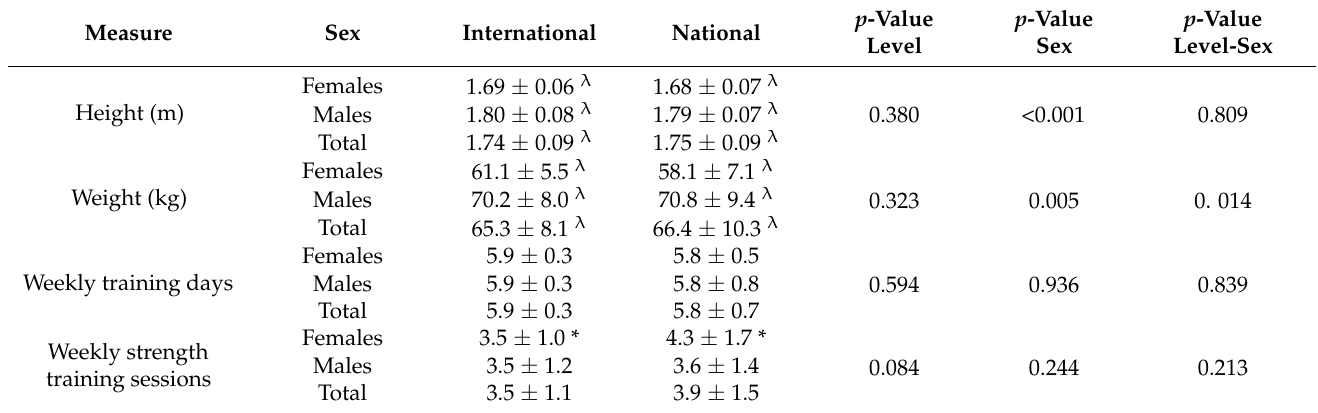
Table 1. Characterization of sample data divided by sex and competitive level (international and